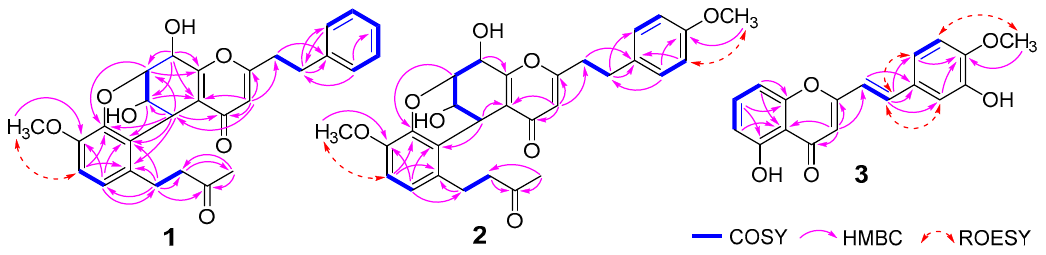
Figure 2. Key 2 D-NMR correlations of 2-(2-phenylethyl)chromone derivatives 1 – 3 of agarwood.